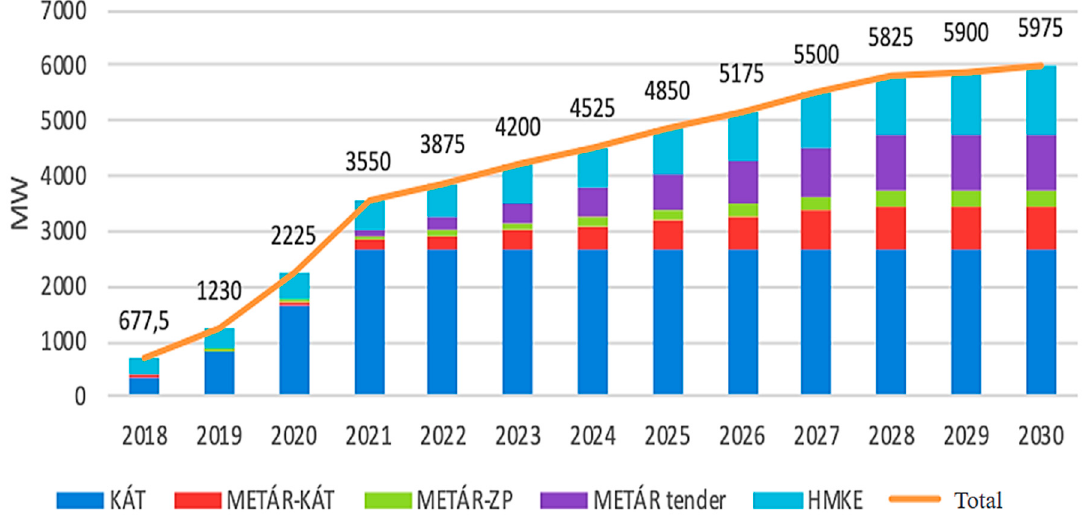
Figure 2. Expected photovoltaic (PV) power in Hungary [51] * (* Hungarian abbreviations of Hungarian PV power plant sizes and support schemes: KÁT—Hungarian system of supporting green energy from renewable energy sources, METÁR—Renewable Energy Support Scheme, ZP—Green Premium, HMKE—household-size small PV power).